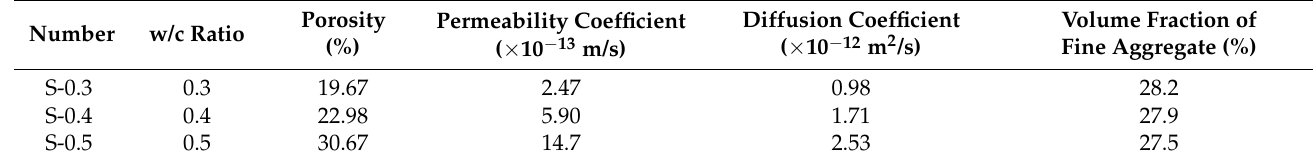
Table 6. Model parameters of the cement mortar block.